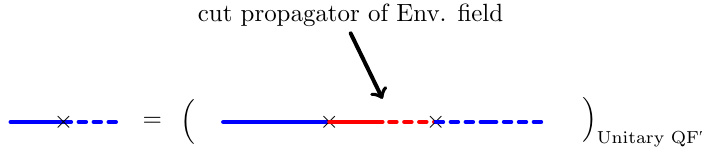
Figure 1. Feynman-Vernon vertex of an open